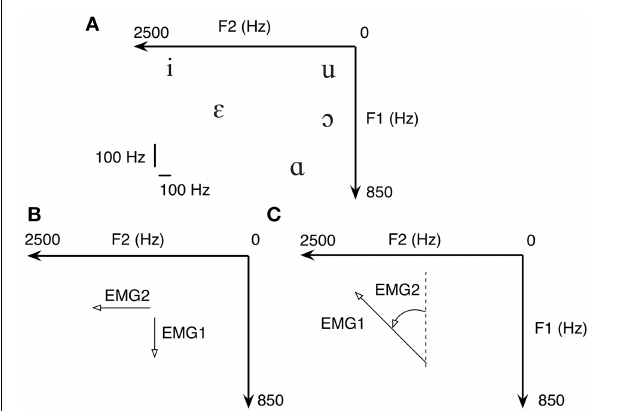
FIGURE 3 | (A) In formant-based speech synthesis, each vowel represents a point on the 2D plane defined by F1 and F2. Therefore, five common U.S. English vowels are one-on-one mapped to five targets on a 2D plane. Both the Cartesian (B) and polar (C) transform from EMG to formant are tested due to the non-negativity of EMG